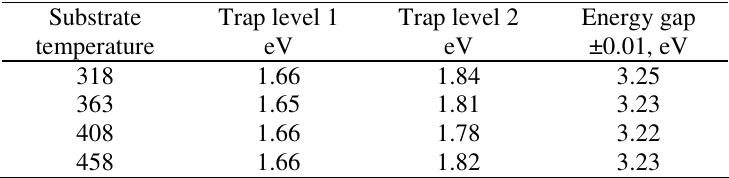
Table 1. The optical band gap energies of cobalt phthalocyanine thin films deposited at different substrate temperatures.